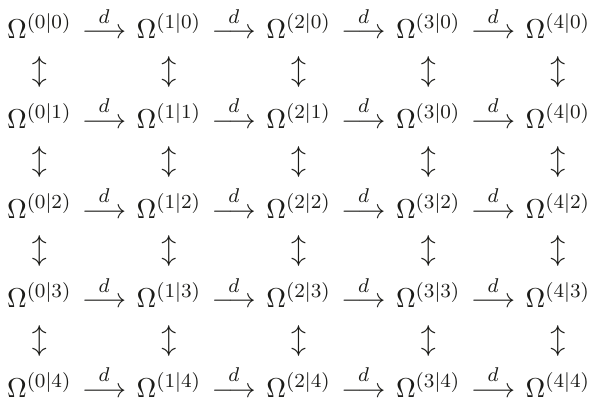
Figure 1 . The complex of pseudoforms for the supermanifold M (4 | 4)